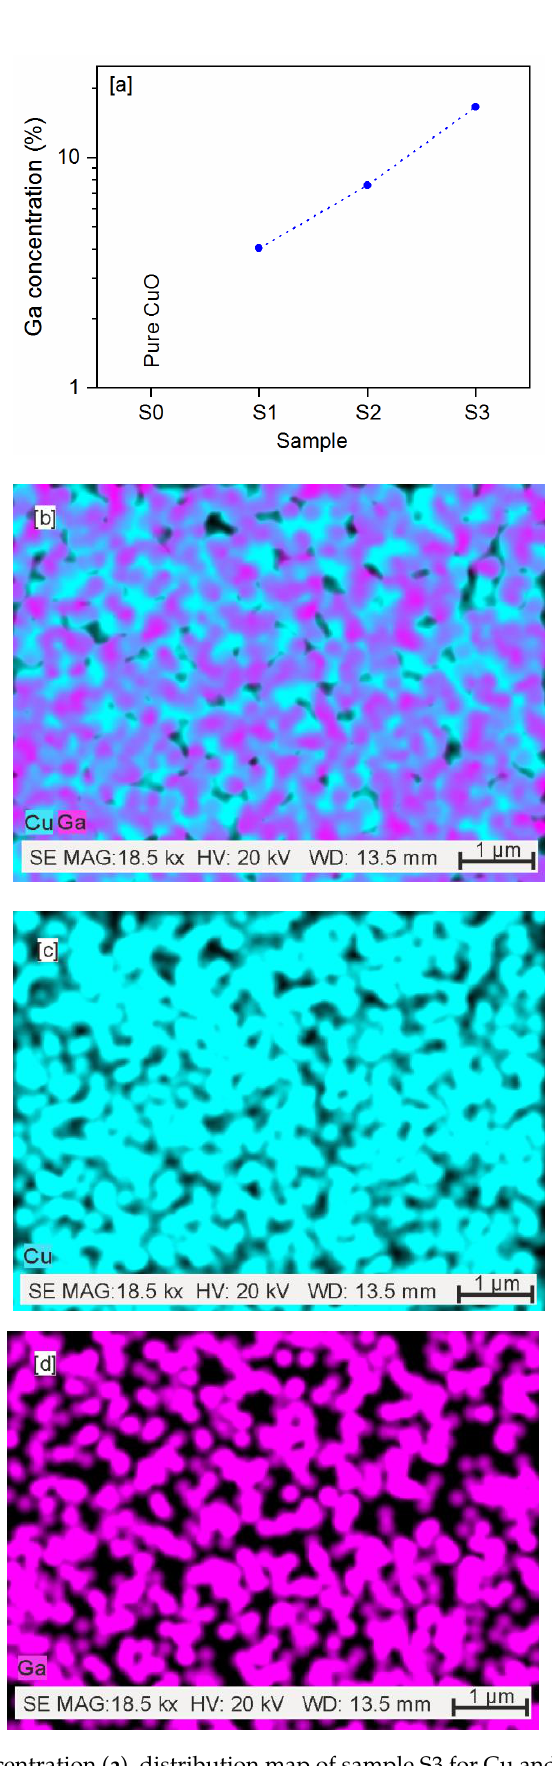
Figure 2. Gallium concentration ( a ), distribution map of sample S3 for Cu and Ga elements ( b ), and distribution maps of only Cu ( c ) and only Ga ( d ) elements for the same sample.